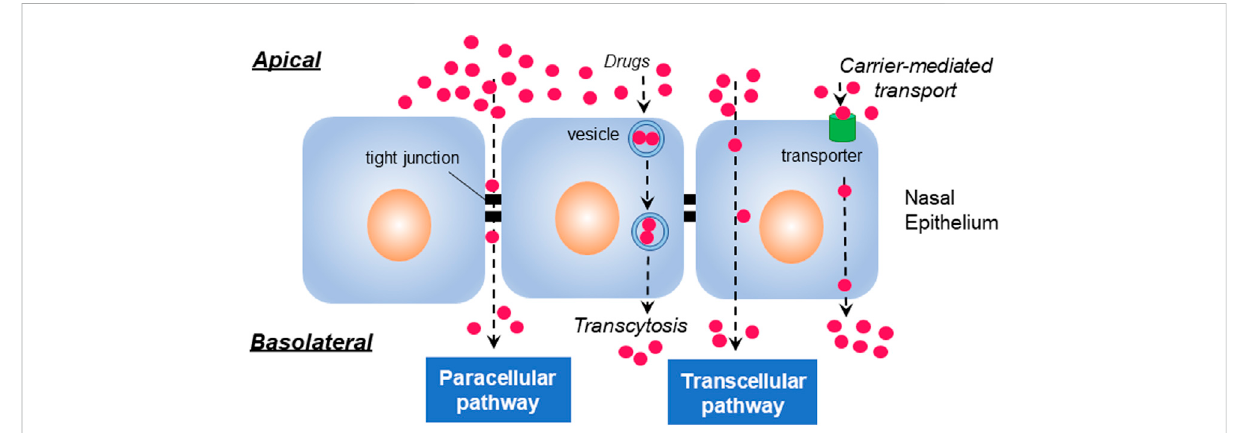
FIGURE 1 Transepithelial pathways. Molecules generally penetrate the epithelial cells through paracellular, transcellular, and transcytotic pathways. The paracellular pathway is used by drugs to passage through intermolecular spaces or tight junctions of epithelium, whereas transcellular translocation is mediated by passive diffusion, carrier-mediated transport, or endocytosis. Transcytosis occurs by vesicular transduction of